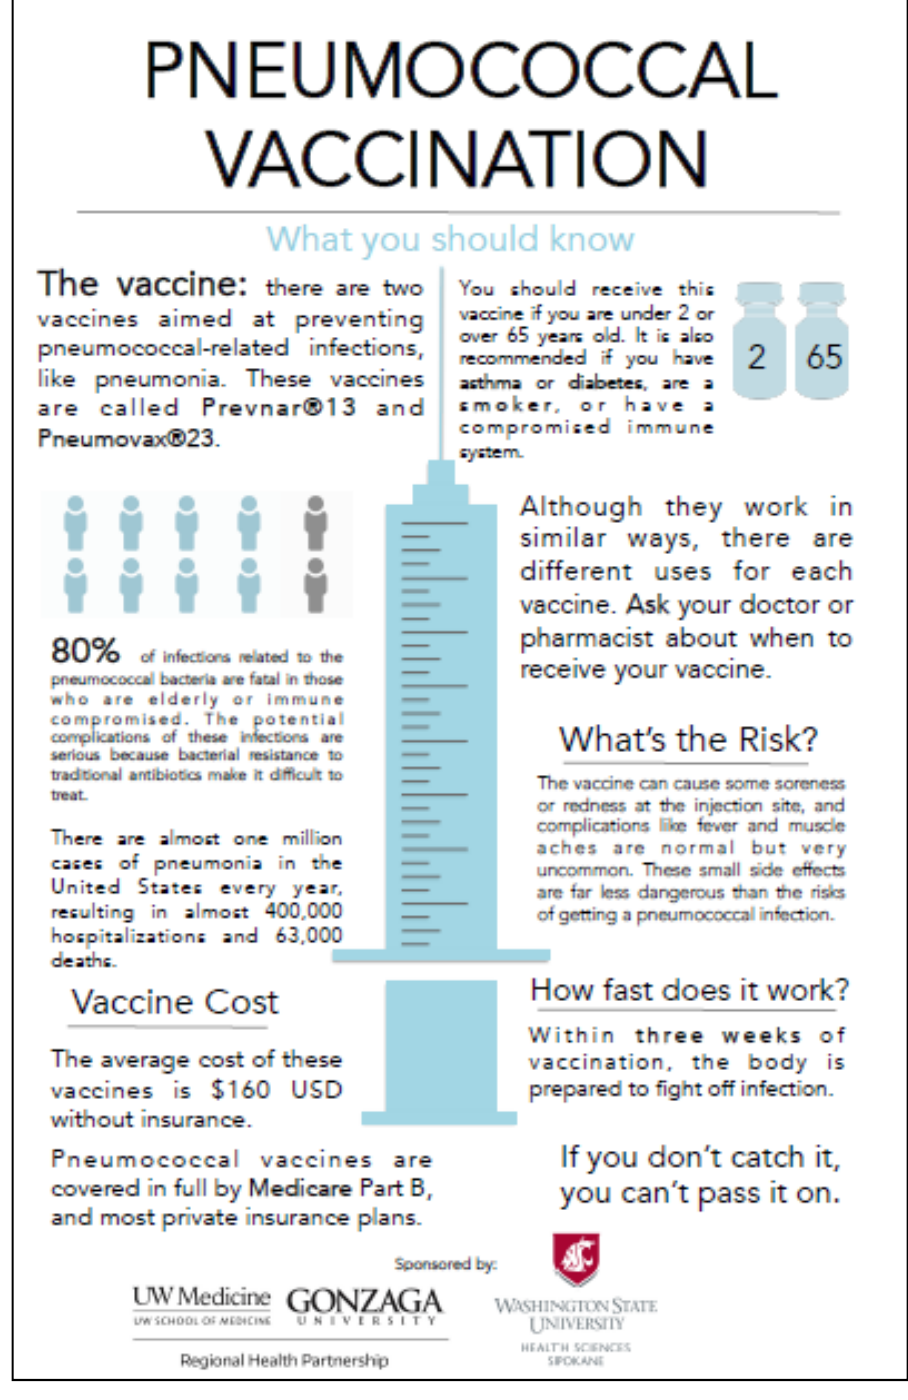
Figure 5. The examination room poster.